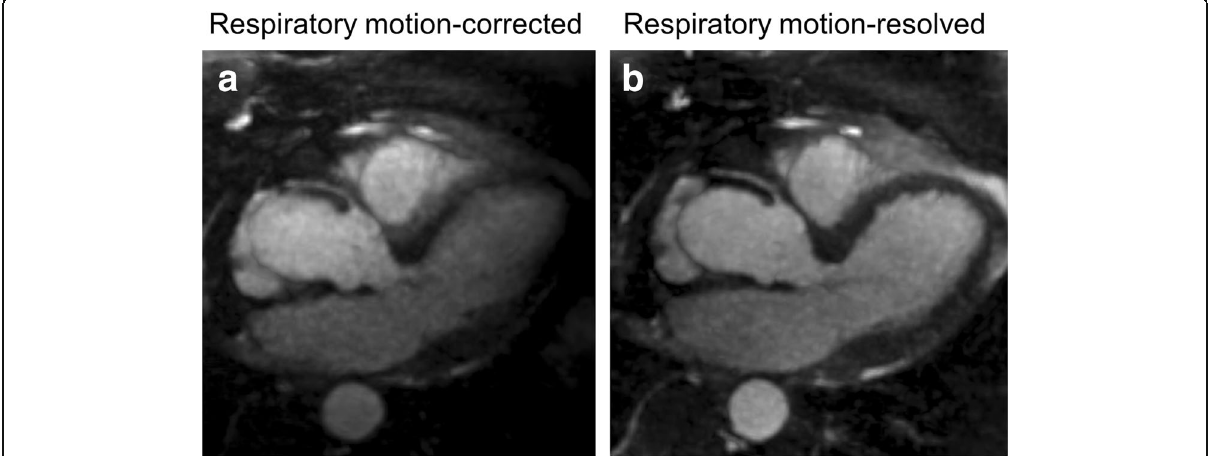
Fig. 3 Left ventricular outflow track view of the heart visualizing the proximal segment of the right coronary artery. Motion-resolved reconstruction ( b ) provides improved sharpness (62.6%) compared to motion correction (50.9%, a